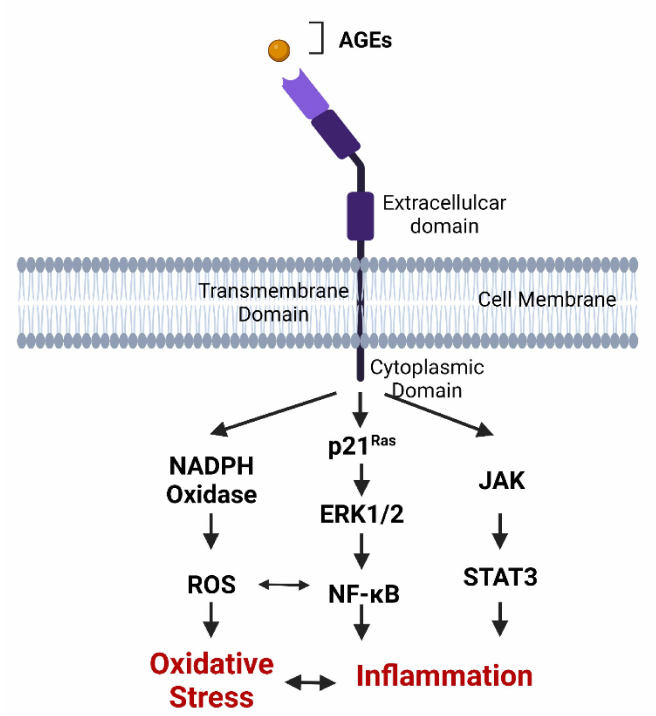
Figure 4. AGE-RAGE signaling. RAGE is composed of three extracellular domains, which include a V type ligand-binding domain and two C domains, one transmembrane domain and a cytoplasmic domain essential for signal transduction. RAGE ligands such as AGE bind to the V domain of RAGE on the cell membrane, leading to the initiation of inflammatory pathways such as JAK-STAT, NADPH Oxidase- NF- κ B, p21 Ras and production of reactive oxygen species resulting in β -cell